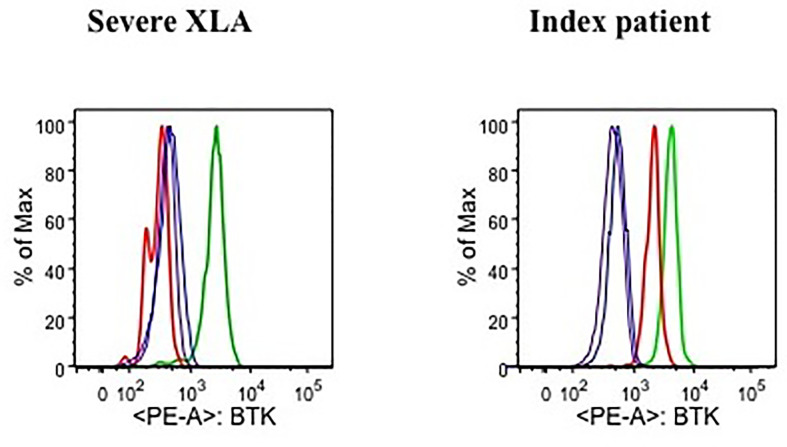
Flow cytometric analysis of BTK expression in a severe XLA patient (left plot) and the index patient (right plot). For each plot, histograms representing BTK expression measured as Mean Fluorescence Intensity (MFI) are presented for the following cell subsets: B lymphocytes of a healthy control (green line), patient’s B lymphocytes (red line), T lymphocytes of a healthy control (blue line), patient’s T lymphocytes (purple line).